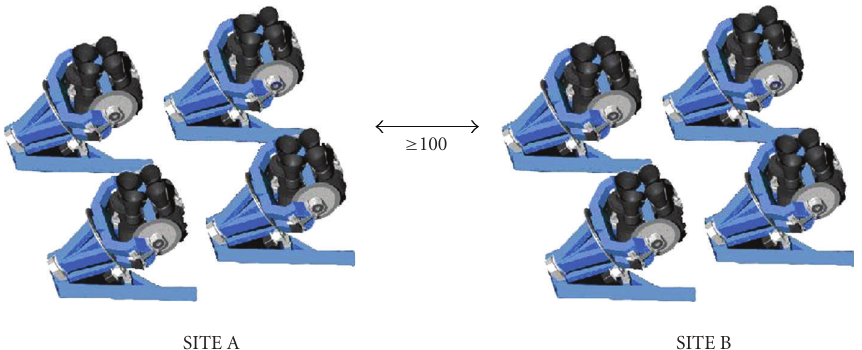
Figure 17: Schematic view of architecture of the Wide-Field